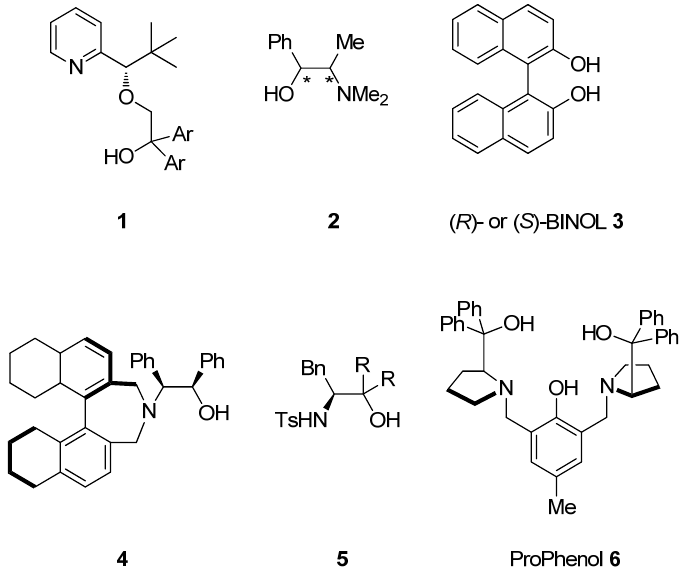
Figure 1. Chiral ligands for the enantioselective addition of alkynylzinc to aldehydes.